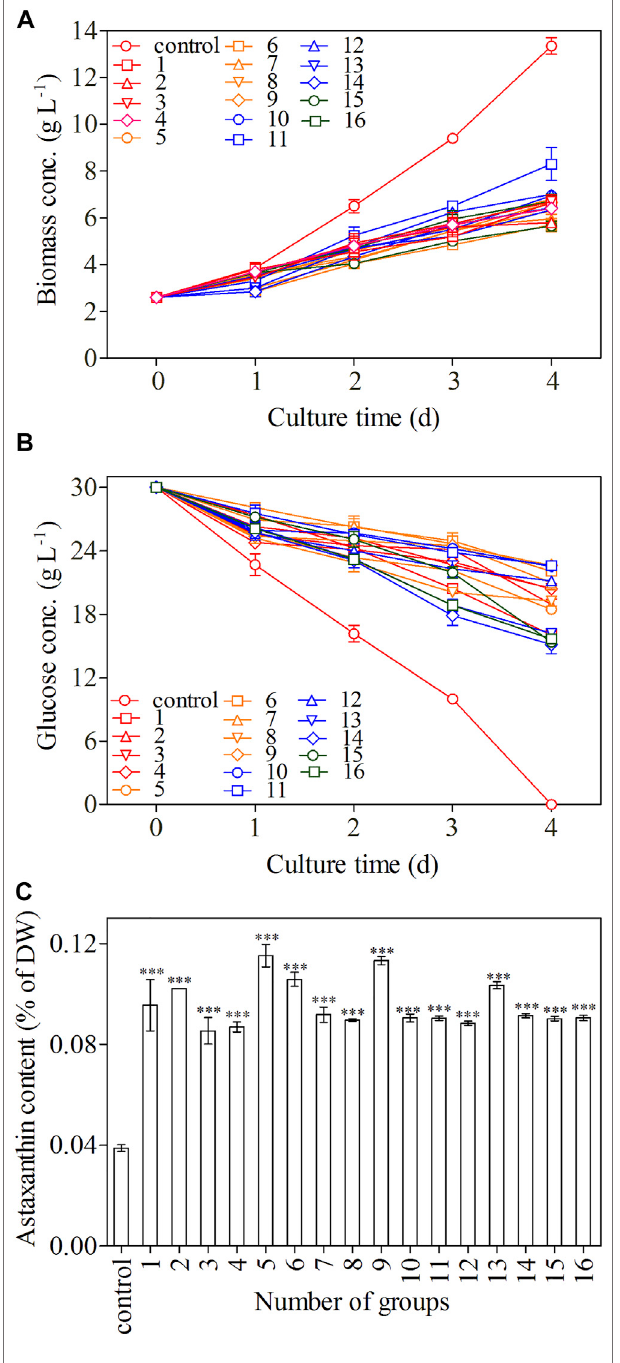
FIGURE 4 | Biomass concentration (A) , glucose concentration (B) , and astaxanthin content (C) of C. zo fi ngiensis in different treatment groups. The biomass concentration, glucose concentration, and astaxanthin content were monitored daily during 4-day induction; astaxanthin content was measured on day 4. All cultures were conducted in Erlenmeyer fl asks with modi fi ed Endo culture medium containing NH 4 Cl as the nitrogen source. Data are mean values ±SD from triplicate measurements (n = 3) (See Table 2 for detailed information on treatment groups 1 – 16).